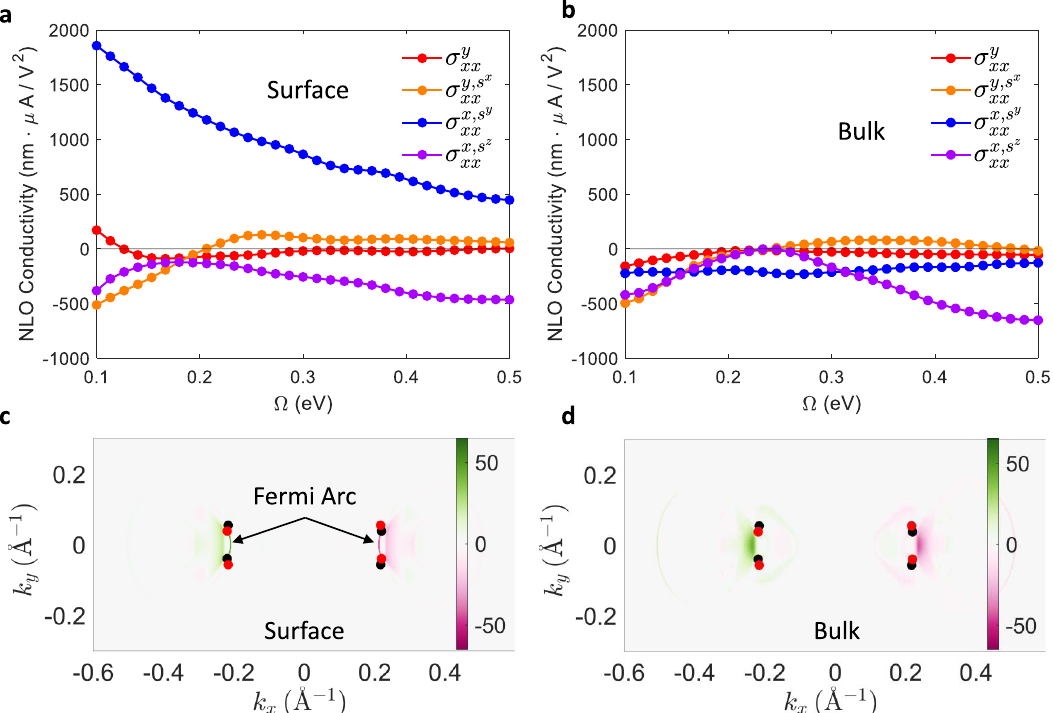
Fig. 3 BSPV conductivity for T d -WTe 2 . Nonzero elements of the conductivity tensor are shown for the ( a ) surface PL and ( b ) bulk PL. c , d Spin density of states, de fi ned as D s y ð k ; E Þ ¼ i Tr s y G r to mark the locations of Weyl points with + 1 and − 1 chirality,